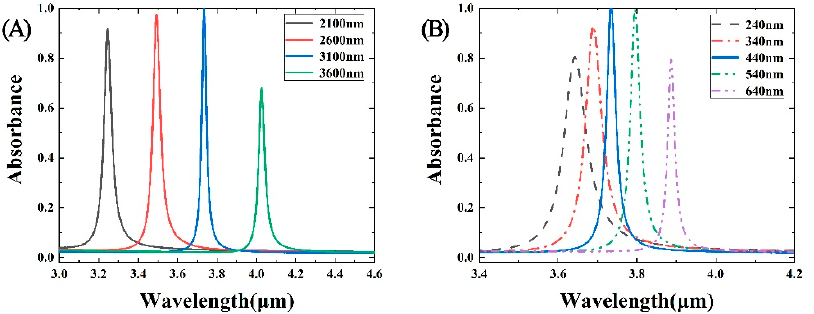
Figure 5. Periodic parameters of symmetrical Si grating ( A ) and spacing parameters of the two secondary gratings ( B ).